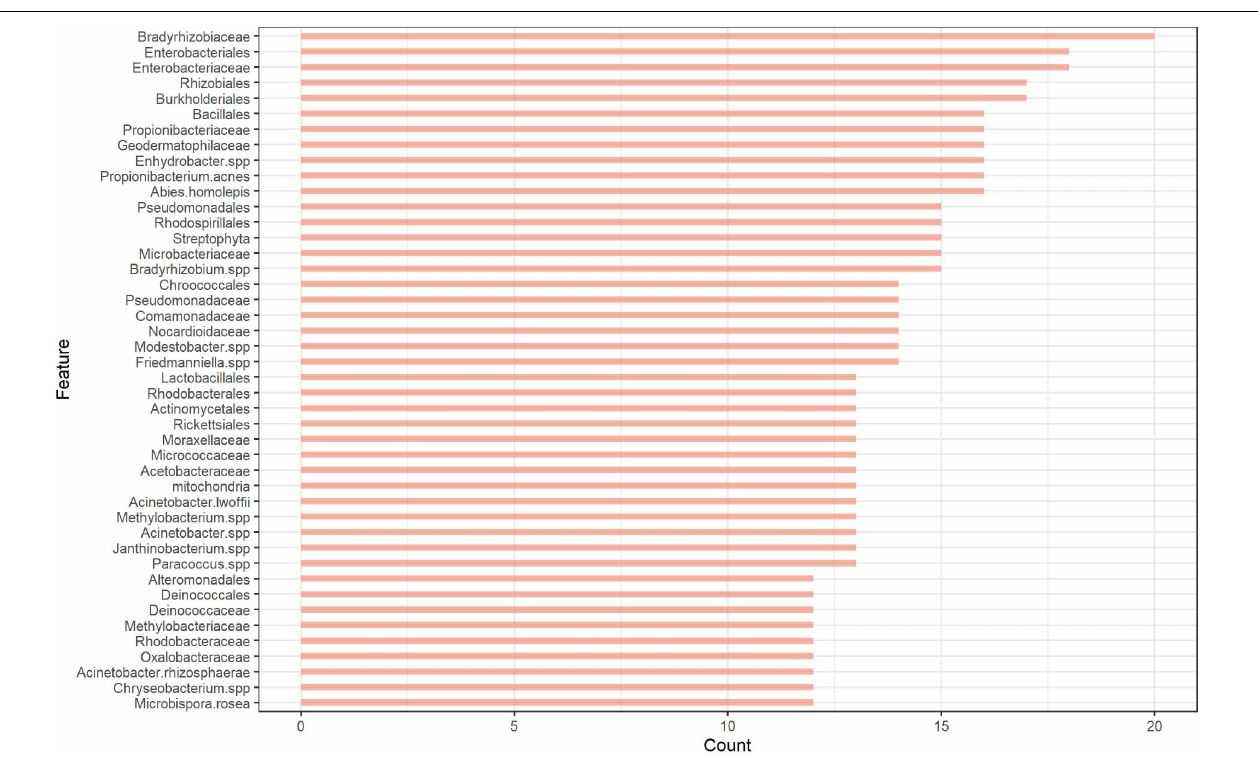
FIGURE 2 | The number of times the features retained by the elastic net logistic regression.